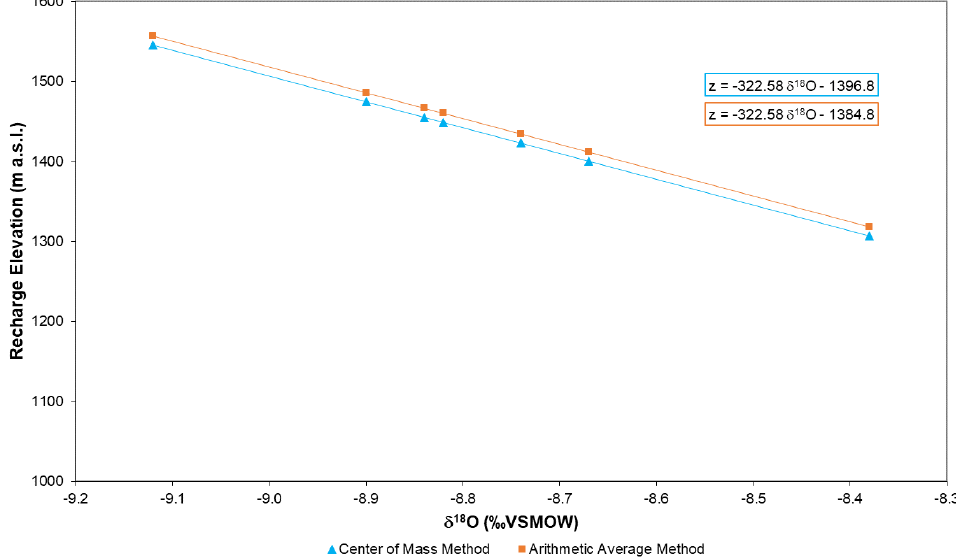
Figure 5. δ 18 O values of spring samples plotted against recharge elevations (October 2002).